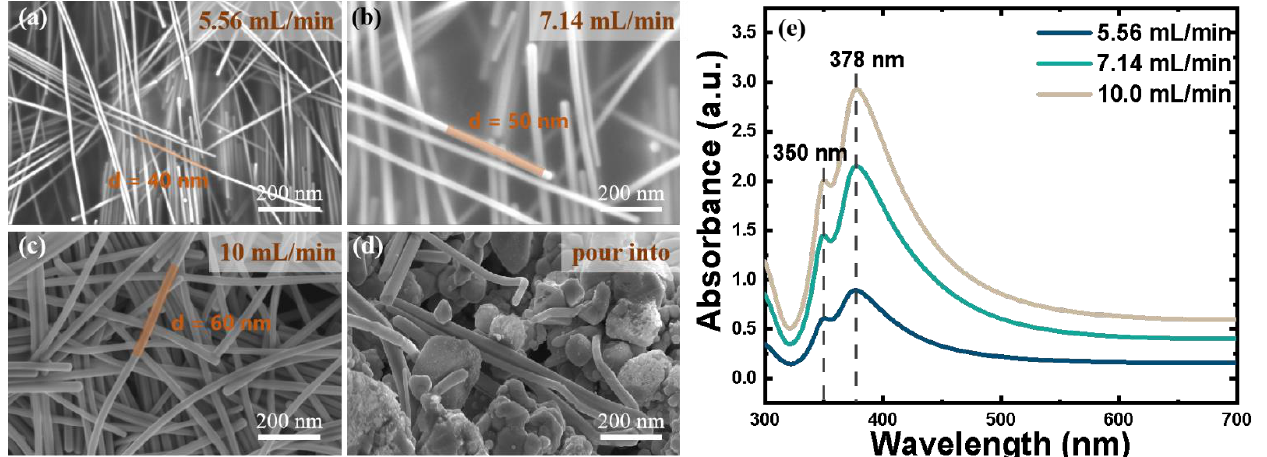
Figure 7. SEM images of AgNWs prepared by dropwise addition of AgNO 3 solution at different speeds: ( a ) 5.56 mL/min, ( b ) 7.14 mL/min, ( c ) 10 mL/min, ( d ) Pour into; ( e ) UV – vis absorption spectra of AgNWs with different dropping accelerations of AgNO 3 solution.